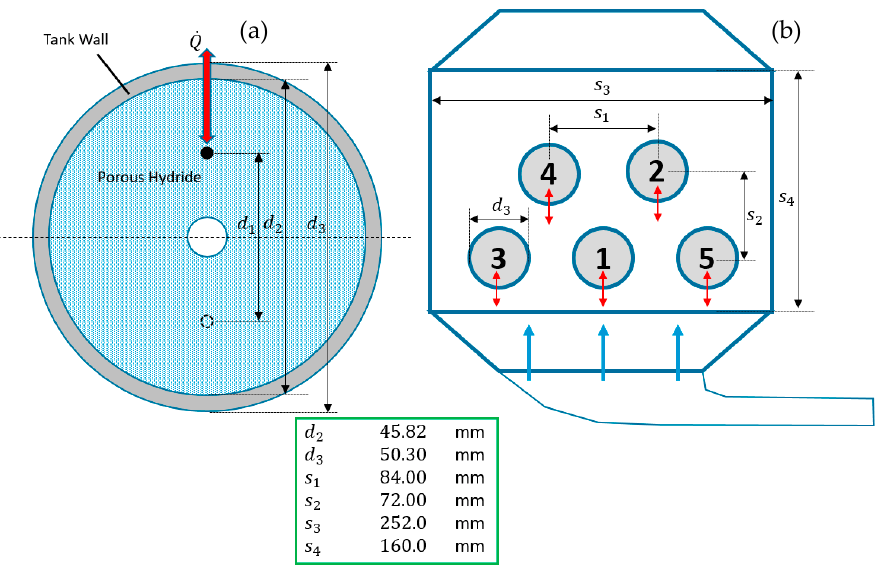
Figure 4. Heat transfer radial lengths in the internal cross-section of a tank ( a ) and disposition of the cylinders bundle inside the heat exchange housing ( b ).